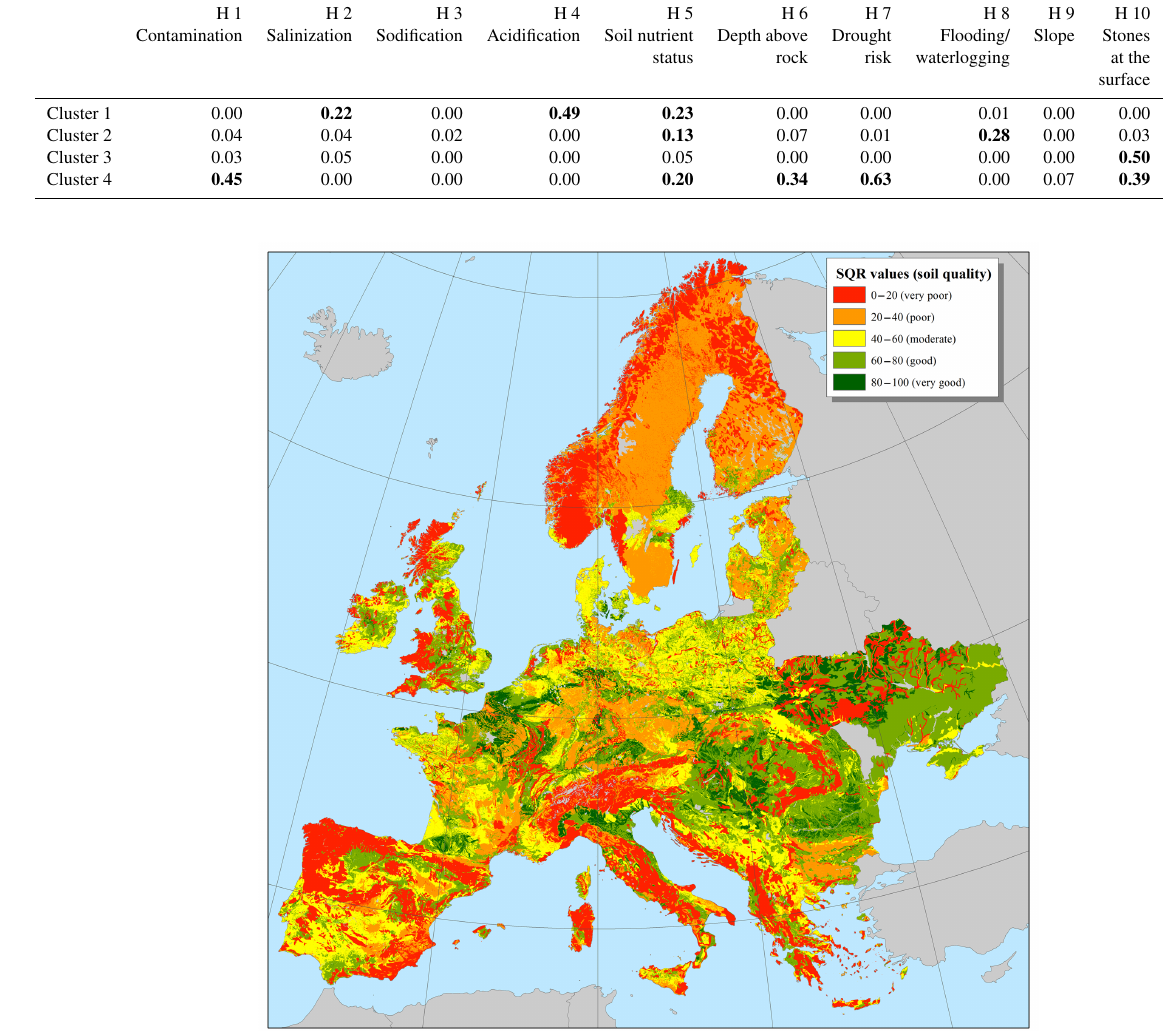
Figure 7. SQR calculation results for Europe taking into account all basic and 11 hazard